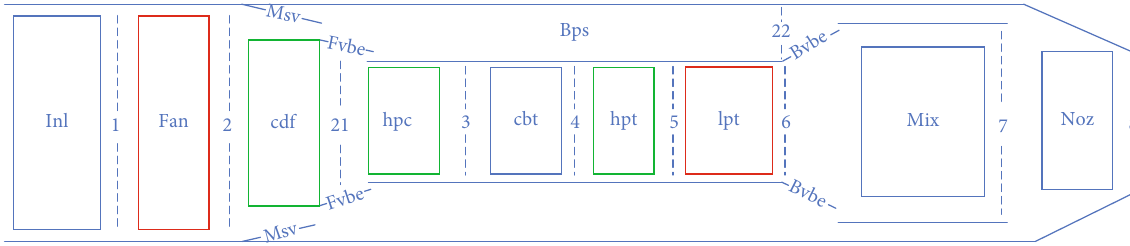
Figure 1: Component-level structure of